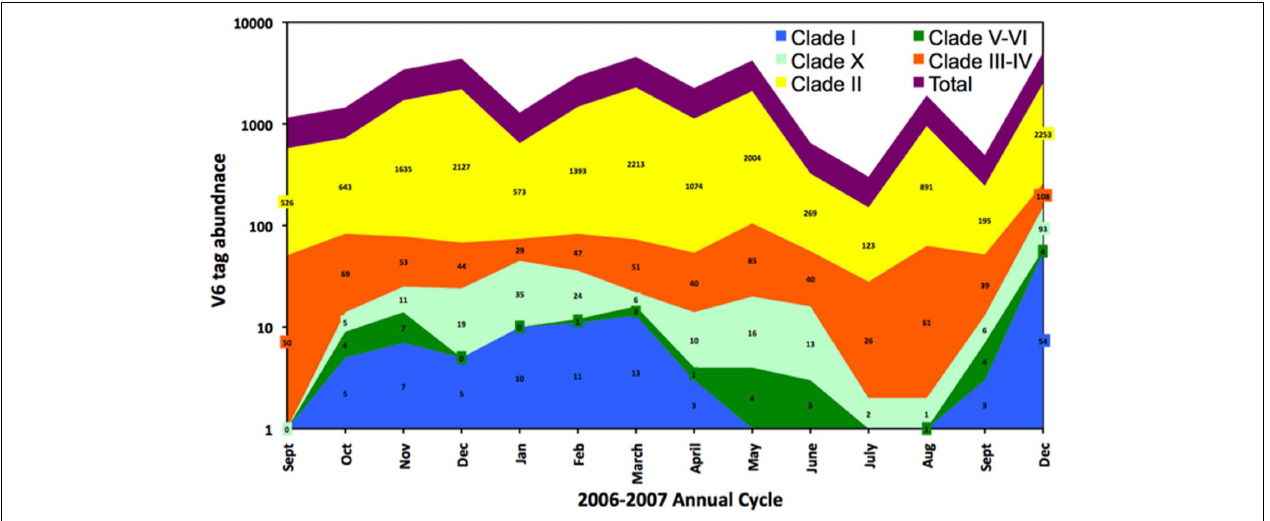
FIGURE 7 |V6 tag abundance of Synechococcus ecotypes in surface layer samples (20m) in the Gulf ofAqaba along a seasonal cycle in 2006–2007. Data labels indicate the actualV6 tag abundance of each clade for individual